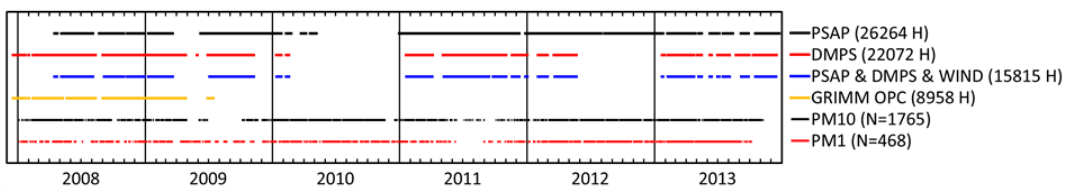
Figure 1. The periods of the PSAP, the DMPS, the Grimm OPC and the PM 1 and PM 10 filter sample data. The number of hours of accepted data and the number of samples are shown in parentheses for the continuous instruments and the filter samplers,